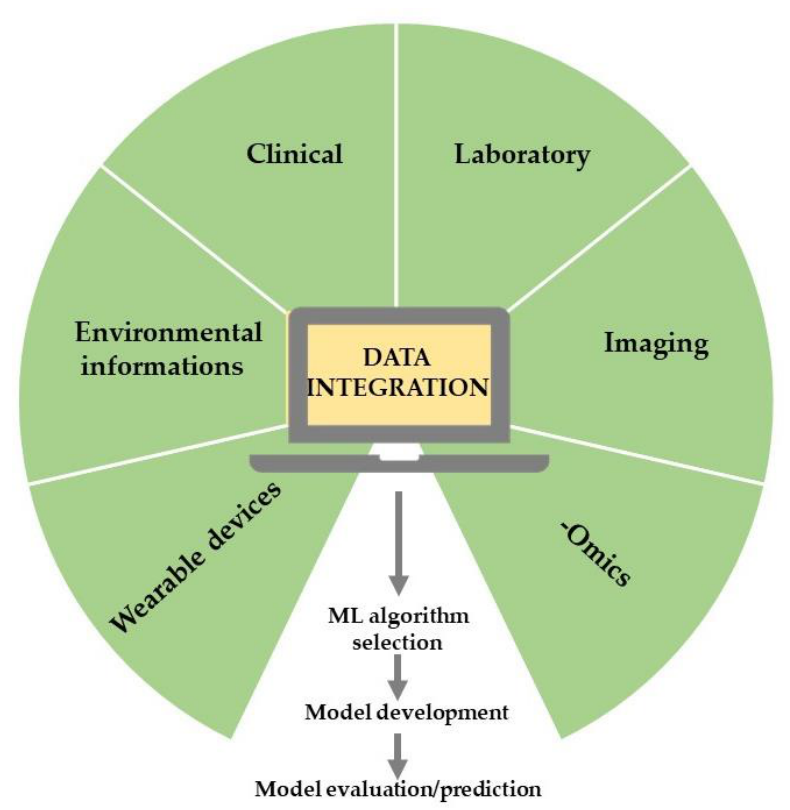
Figure 1. The typical ML workflow in healthcare research.